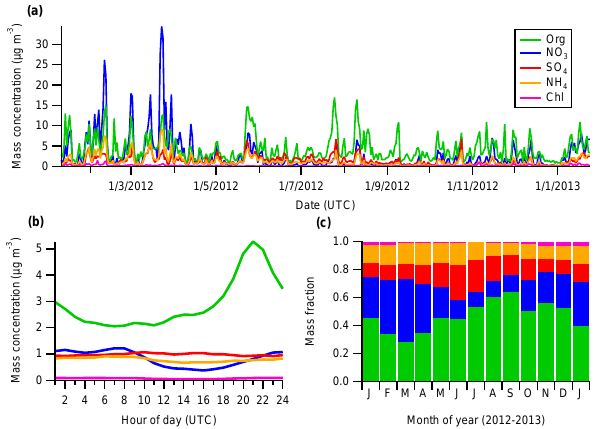
Figure 1. (a) Daily averaged time series of all NR-PM 1 species. (b) Median diurnal profiles of all NR-PM 1 species. (c) Average monthly fractional contribution of all species to total NR-PM 1 . The months are grouped as seasons: January 2012, February, Decem- ber, and January 2013 are in winter; March, April, and May are in spring; June, July, and August are in summer; September, October, and November are in autumn.